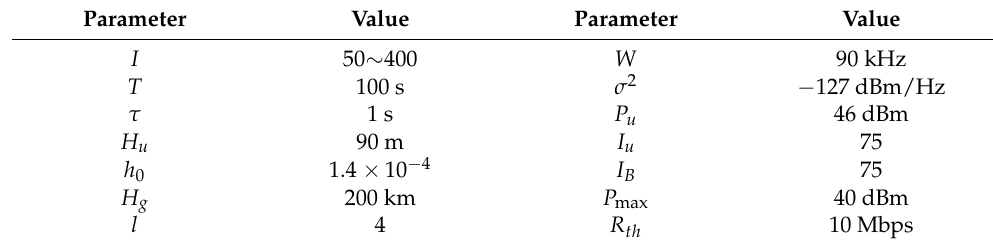
Table 1. System model simulation parameters.